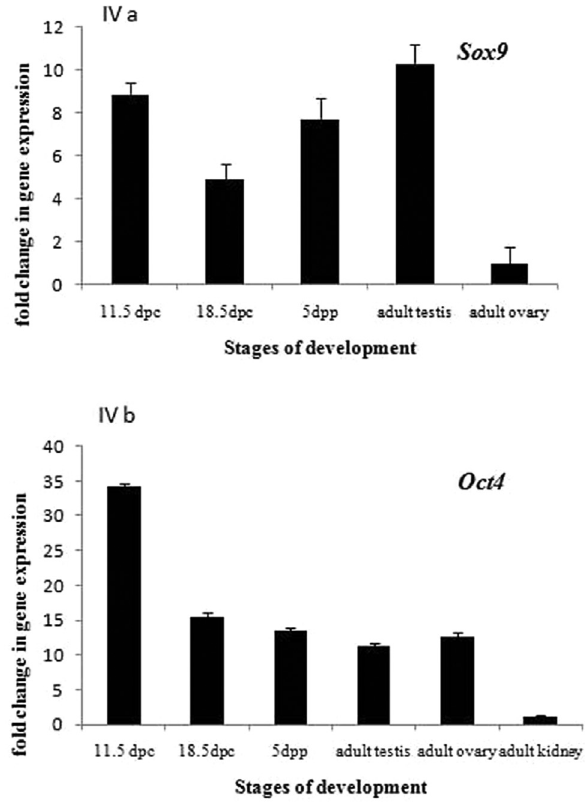
Figure 4 - Expression pattern of Sox9 ( A ) and Oct4 (B) transcript in the testisatdifferentdevelopmentalstagesandinadultovaryandadultkidney (in Oct 4 only) through Real-time PCR ( (cid:3) Ct for Sox9 and Oct4 was calcu- lated for each stage in all tissues). GAPDH was taken as internal control. All results are shown as the means (cid:6) S.D and are considered significant at p (cid:7) 0.05. For calculating (cid:3)(cid:3) Ct, (cid:3) Ct value of calibrator was subtracted from (cid:3) Ctvalueofeachsample.Foldchangeingeneexpressionwascalcu- lated according to 2 - (cid:3)(cid:3) Ct